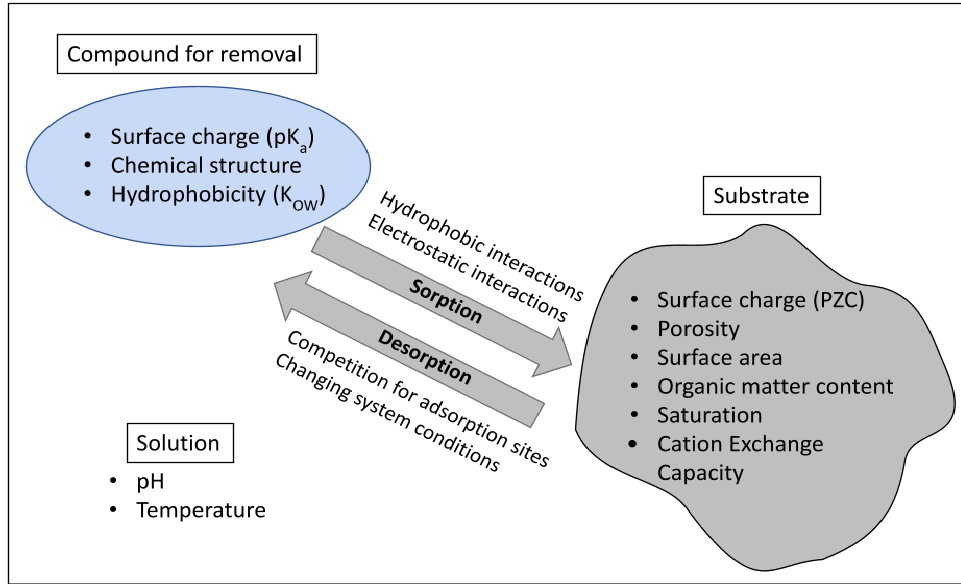
Figure 2. Influencing parameters in the sorption of emerging contaminants to substrate in constructed wetlands. These parameters are not listed in order of relevance or influence in a system.